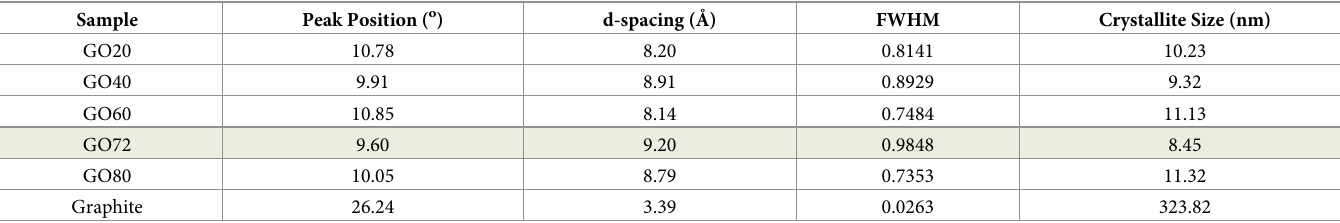
where D is the crystallite size of the sample, K is the Scherrer constant (0.9), λ is the X-ray wavelength (0.15406 nm), β is the width of XRD peak at half height (FWHM), and θ is the Bragg diffraction angle. The crystallite size of GO ranges from 8.45 nm to 11.32 nm regardless Table 2. Peak position, d-spacing, FWHM, and crystallite size of GO and graphite. Sample Peak Position ( o ) d-spacing ( Å ) FWHM Crystallite Size (nm) GO20 10.78 8.20 0.8141 10.23 GO40 9.91 9.32 GO60 10.85 11.13 GO72 9.60 0.9848 8.45 GO80 10.05 8.79 11.32 Graphite 26.24 3.39